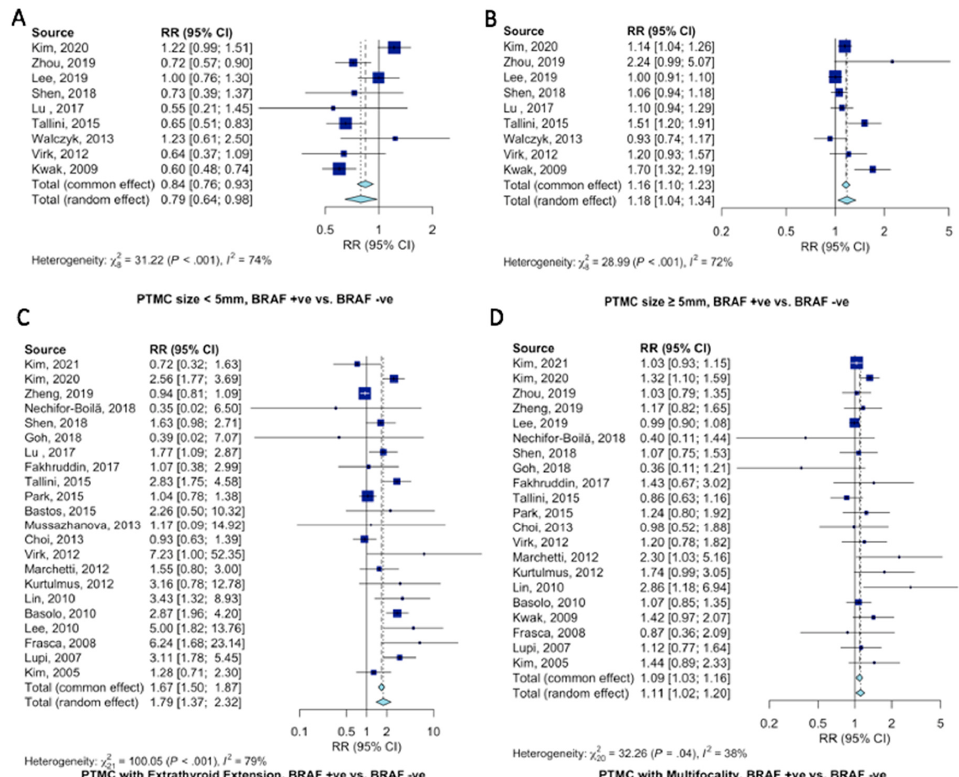
Figure 3. Pooled analysis of clinicopathological characteristics in PTMC patients according to BRAF V600E gene mutation. Forest plots for ( A ) PTMC < 5mm [11,12,16,18,20,22,26,30,37], ( B ) PTMC ≥ 5mm [11,12,16,18,20,22,26,30,37], ( C ) extrathyroidal extension [10,11,13,17–24,27,29,30,32–36,39,41,42], and ( D ) multifocality [10–13,16–19,21–23,29,30,32–35,37,39,41,42]. Compared to patients with wild-type BRAF V600E PTMC, patients with BRAF V600E -mu- tant PTMC were at 43% increased risk of presenting with LNM (RR = 1.43, 95%CI = 1.19– 1.71, Figure 4A). Specifically, BRAF V600E mutation increased the risk of central lymph node metastasis 36% (RR = 1.36, 95%CI = 1.08–1.71, Figure 4B). Seemingly, since PTMC typically spread through the central compartment, there only tended to be an increase in lateral LNM (RR = 1.28, 95%CI = 0.60–2.74, Figure 4C).